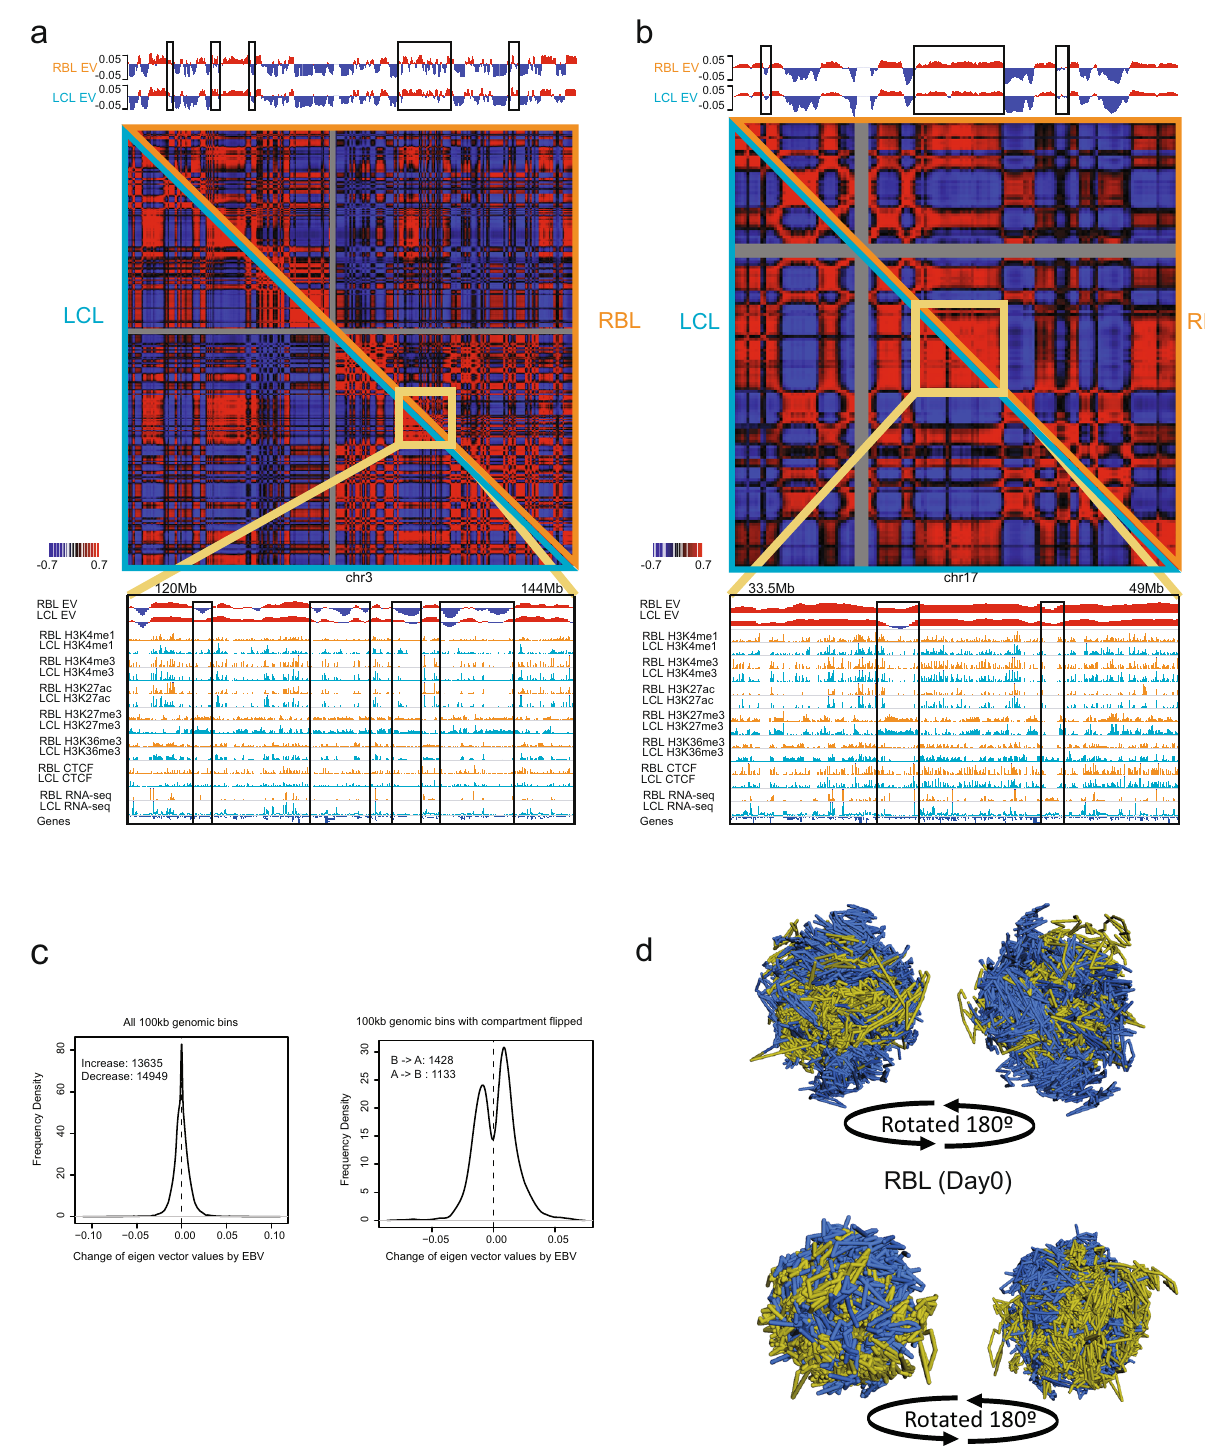
Fig. 1 | RBL and LCL Hi-C interaction maps. Hi-C correlation maps of resting B lymphocytes (RBL, orangetriangle) compared to LCLs (LCL, tealtriangle).Pearson correlation (red as high; blue as low) based on normalized interaction frequencies at 500kb resolution are on the left. Eigenvector values for calling A (red) and B compartments (blue) are shown on top, while the ChIP-seq tracks of histone modi fi cations, CTCF, and RNA-seq in RBLs and LCLs are shown at the bottom for theregionsoutlinedinyellow. a Chromosome3,120Mbto144Mb. b Chromosome 17,33.5Mbto49Mb.Benjamini-Hochbergadjustedp-valuesare9.3e-57and1.5e-22